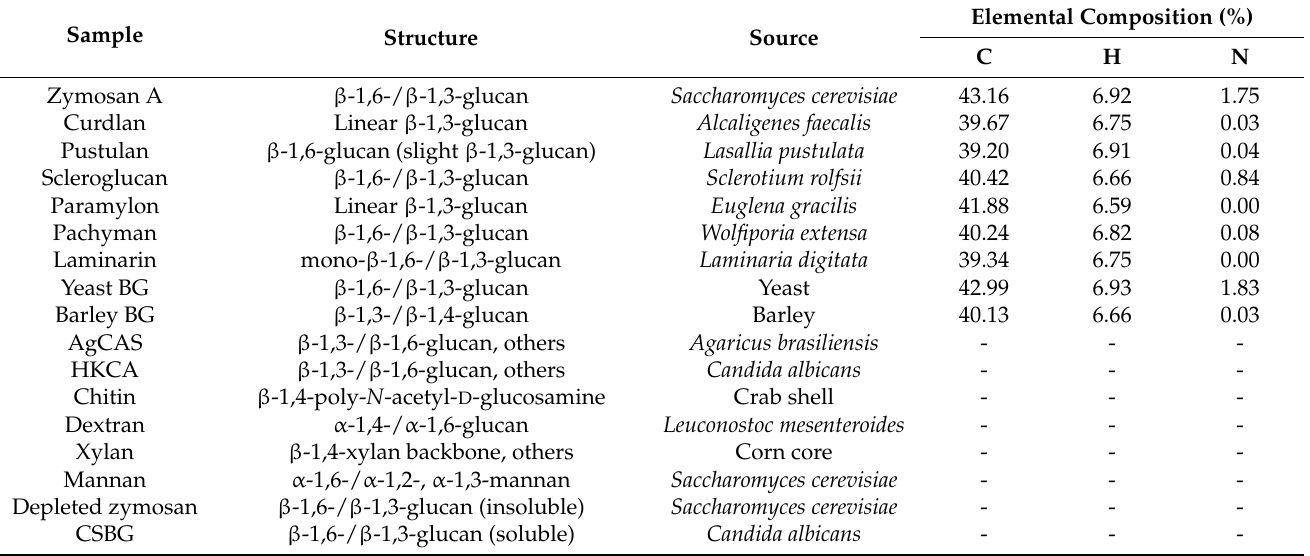
Table 1. Polysaccharides used in this